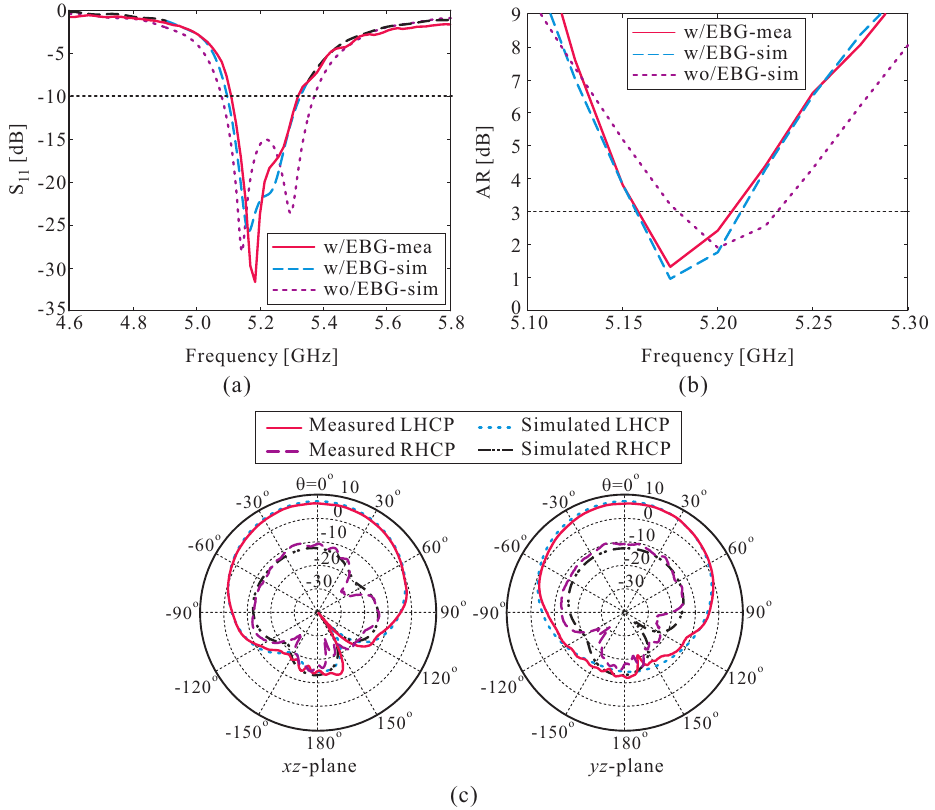
Figure 4. Measured and simulated results of the single CP Koch-shaped patch antenna with the EBGs: ( a ) reflection coefficients; ( b ) ARs; and ( c ) radiation patterns at 5.2 GHz. AR: Axial